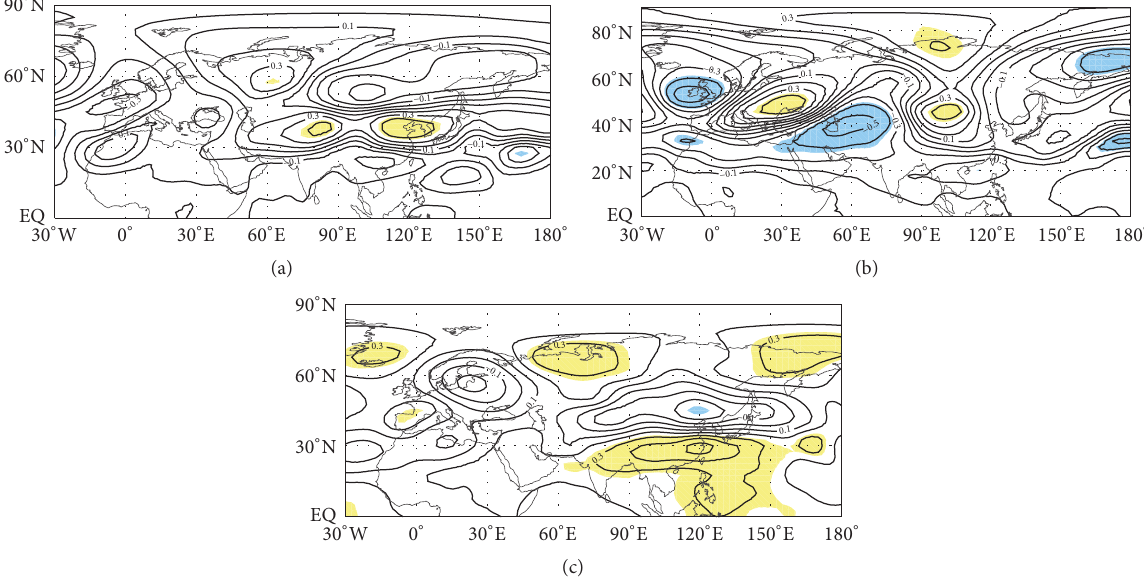
Figure 6: The correlation maps between PCs time series of coefficients and summer 200 hPa GPH for the periods 1961–1979 and 1980–2013. (a) PC1 for 1961–1979, (b) PC2 for 1961–1979, and (c) PC2 for 1980–2013. The shading (yellow for positive correlation and blue for negative correlation) exceeds 90% confidence level based on a two-tailed Student’s 𝑡